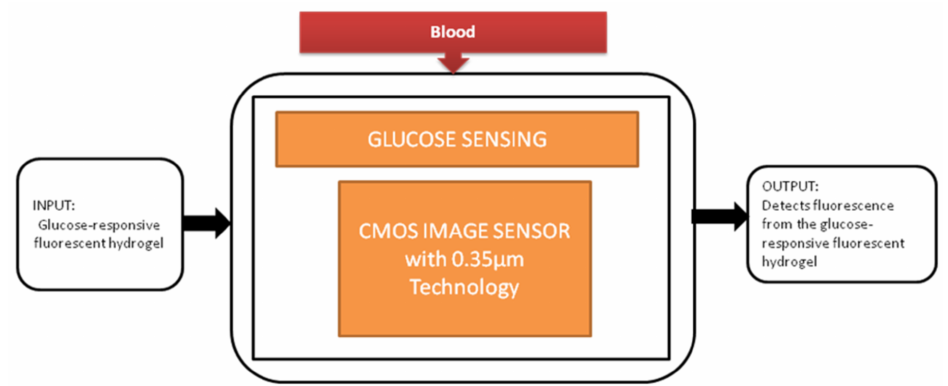
Figure 9. Implantable glucose sensing system.